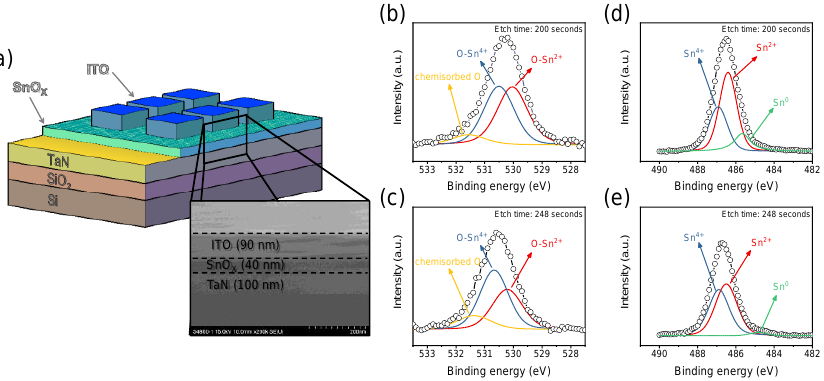
Figure 1. ( a ) The schematic image of ITO/SnO X /TaN device and FE-SEM image includes the thickness information of each layer. The O 1s core-level spectra of ( b ) ITO/SnO X interface and ( c ) SnO X /TaN interface. The Sn 3d 5/2 core level spectra of ( d ) ITO/SnO X interface and ( e ) SnO X /TaN interface. The XPS analysis was conducted through the Shirley background and GL(10). Table 1. Percentage of oxygen – tin bonds in ITO/SnO X /TaN RRAM device. Area was calculated at the core level of O 1s and Sn 3d, respectively.